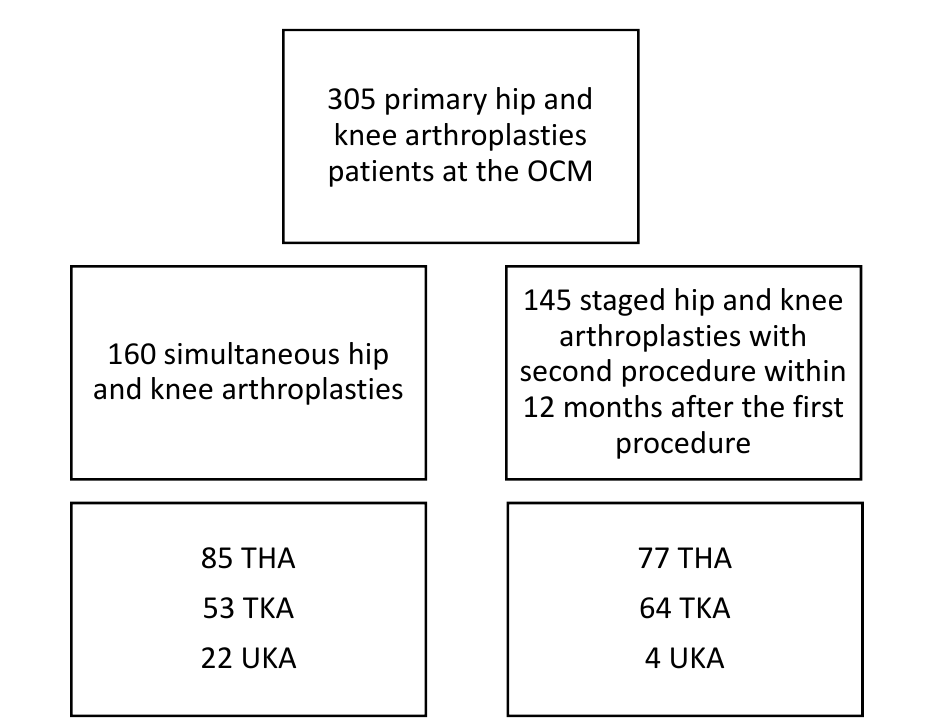
Figure 1. Flowchart of the study’s selected patients. THA: Total hip arthroplasty, TKA: Total knee arthroplasty, UKA: unicompartmental knee arthroplasty.